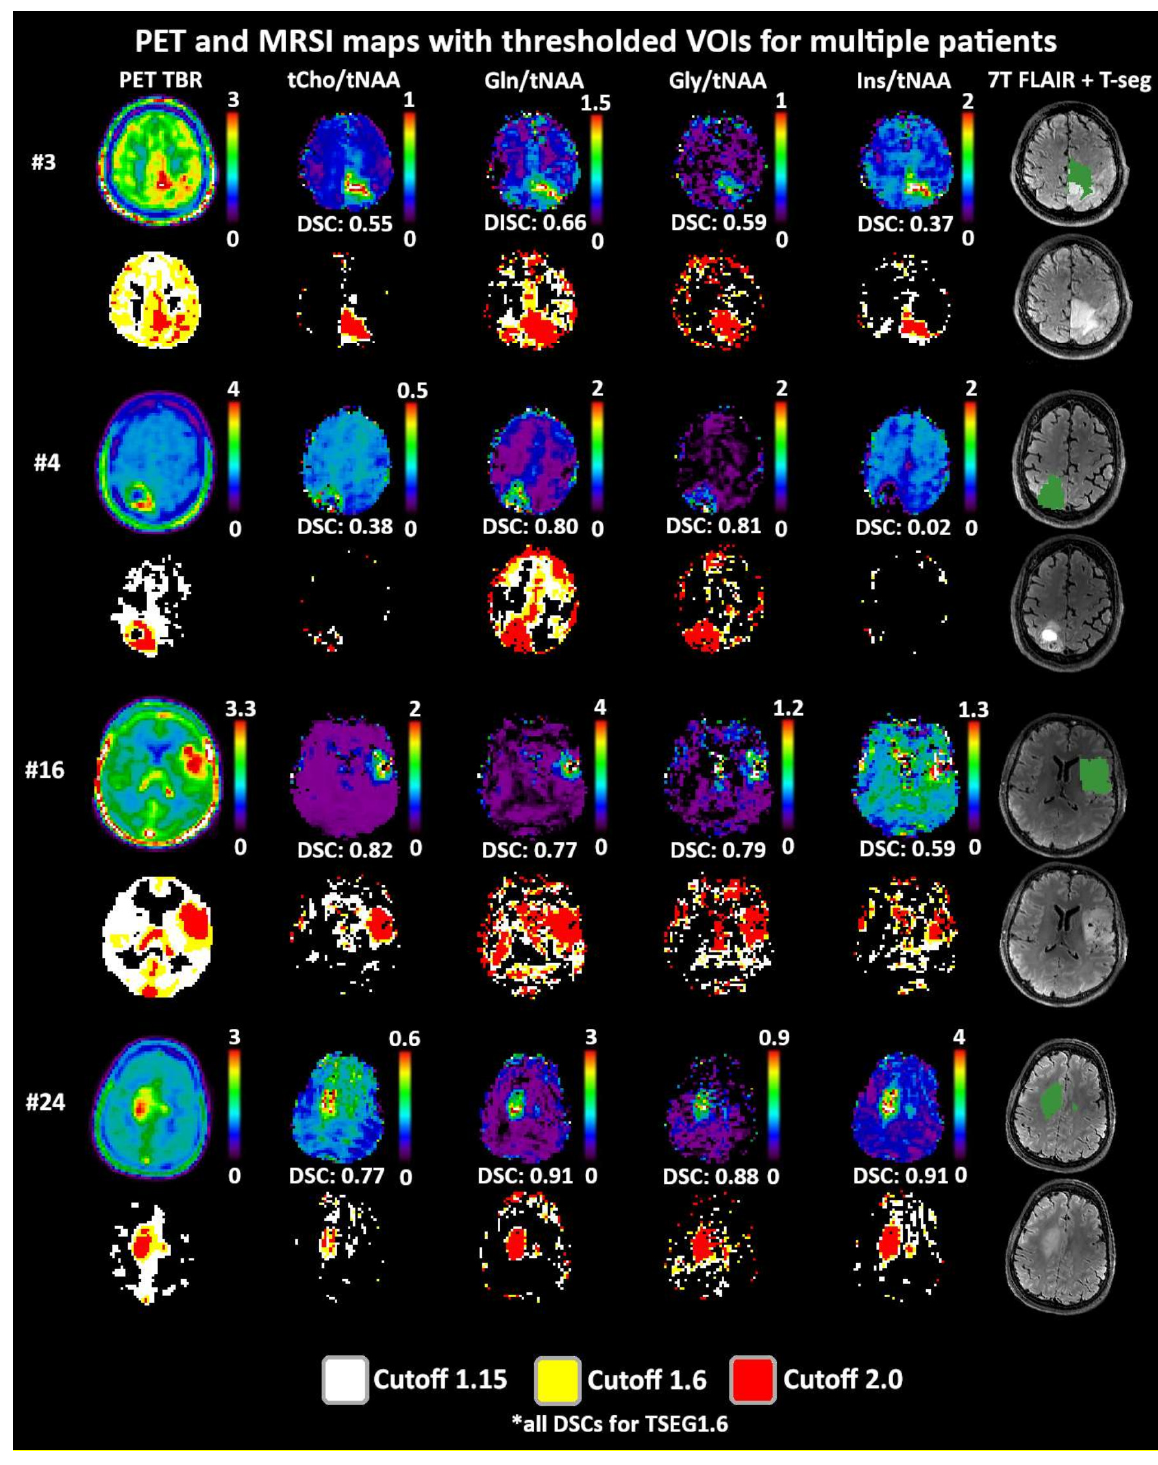
Figure 3. Overview of metabolic ratio images, PET TBR images, and the different applied thresholds, together with tumor segmentation for four patients. Heterogeneity between the different ratio maps is quite visible, as are the differences between cutoff values. The actual evaluation as performed only within the defined tumor segmentations is shown in green. PET maps were resampled to MRSI resolution.